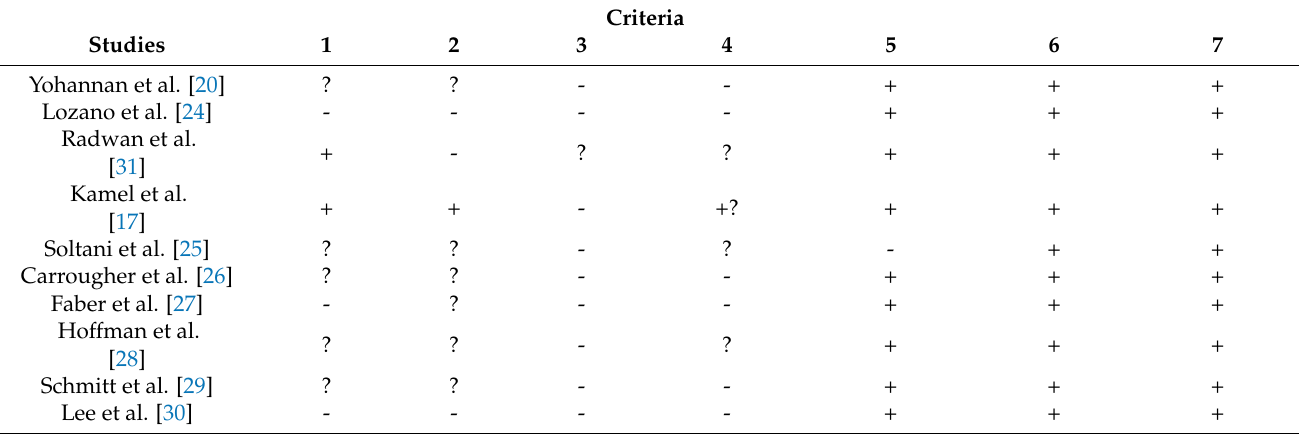
Table 4. Risk of